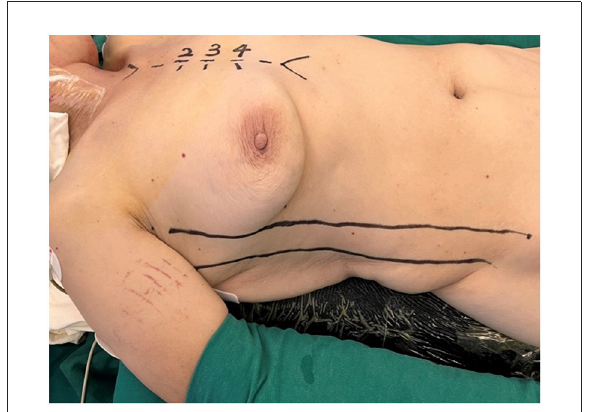
FIGURE1 The patient was positioned supine with the right hemithorax elevated 20–30 degrees, the right upper limb was placed parallel to the body, and the elbow joint was slightly